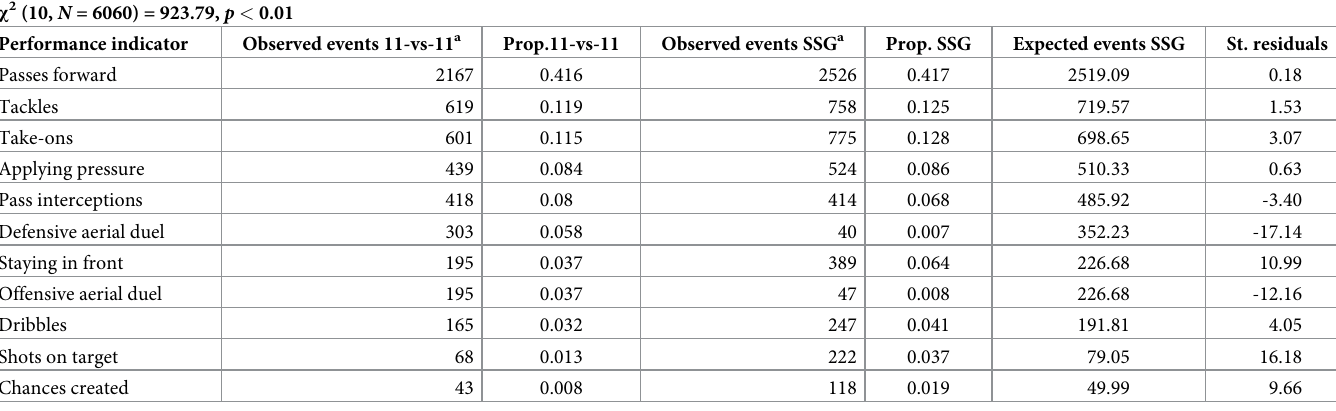
Prop = proportion; st. = standardized. a used to assess the correlation between the distribution of events in both game